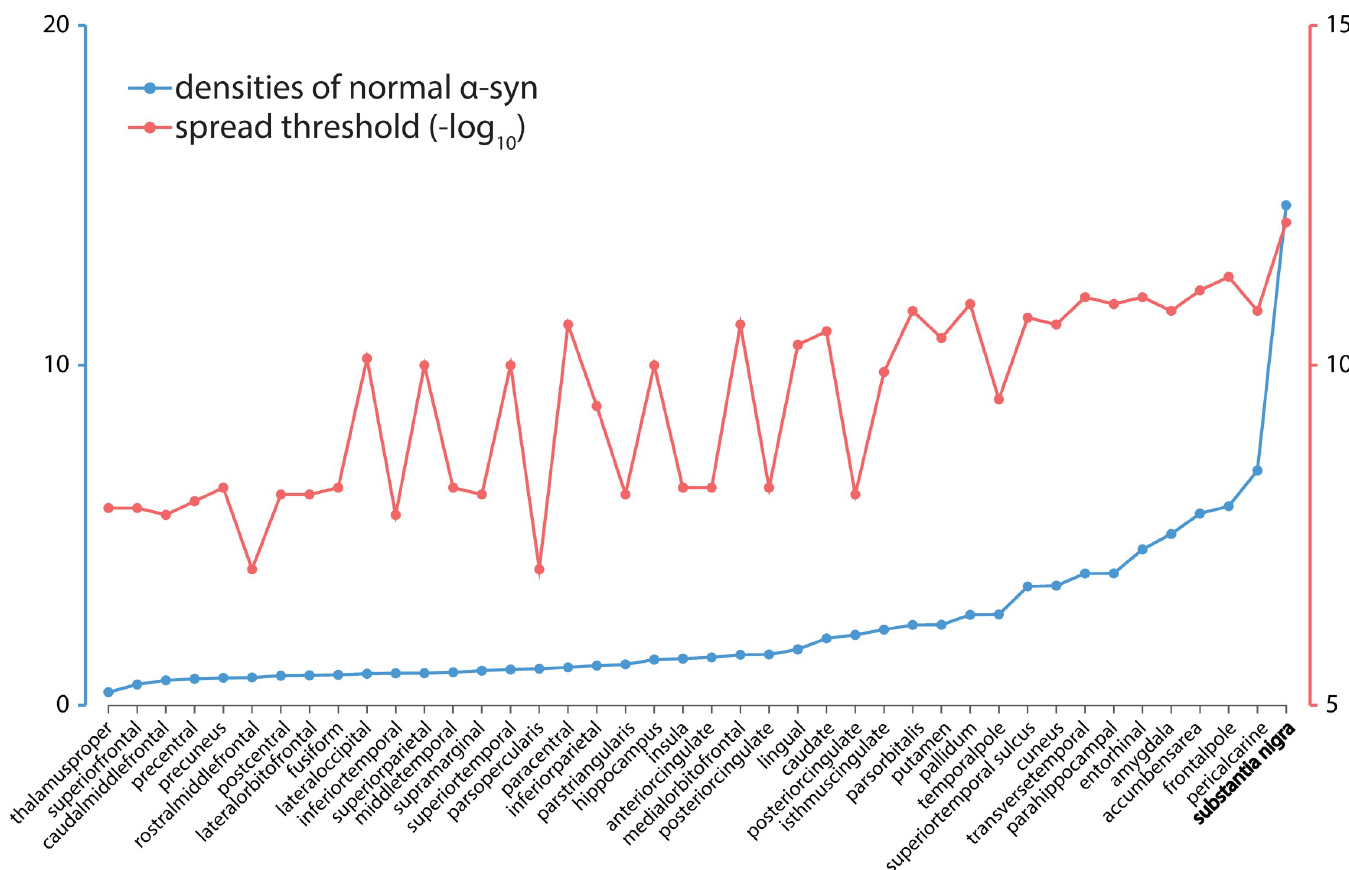
Fig 4. Identifying the disease epicenter. Densities of normal α -synuclein (blue) at equilibrium (represented by the stable point) and spread threshold (red). Spread threshold was inverted by − log 10 , so higher values indicate lower thresholds. Spread thresholds reflect the susceptibility of a region to trigger an epidemic. Basal ganglia regions are rich in endogenous α -synuclein (caudate ranks among the top 42.9% of regions; putamen, 31.0%; pallidum, 28.6%) and have relatively low spread threshold (caudate ranks among the lowest 35.7%; putamen, 38.1%; pallidum, 16.7%). Substantia nigra has the highest normal α -synuclein level and lowest spread threshold, making it the most probable epicenter of disease outbreak. The underlying data can be found at https://github.com/yingqiuz/SIR_simulator/blob/master/results/Fig4.mat. α -syn, α -synuclein.